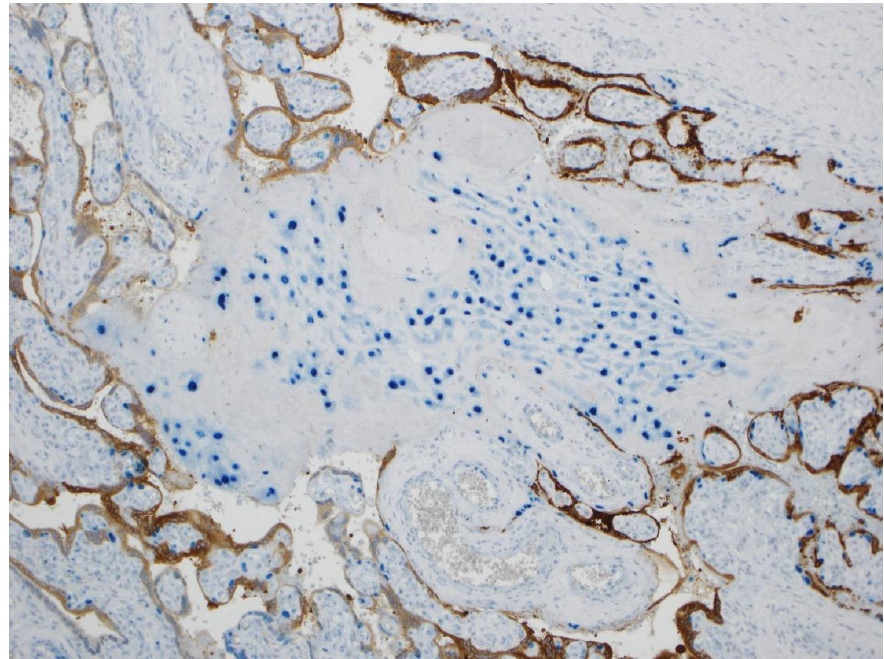
Figure 7. In this double-stained preparation the nuclei of the intermediate trophoblast stain positively (blue) using antibody to GATA3, but the cells are negative for viral staining using antibody to SARS-CoV-2 nucleocapsid protein. Syncytiotrophoblast in the surrounding chorionic villi stain positive (brown) for viral antigen. Double staining with antibodies to GATA3 and SARS-CoV-2 nucleocapsid protein, ×10.